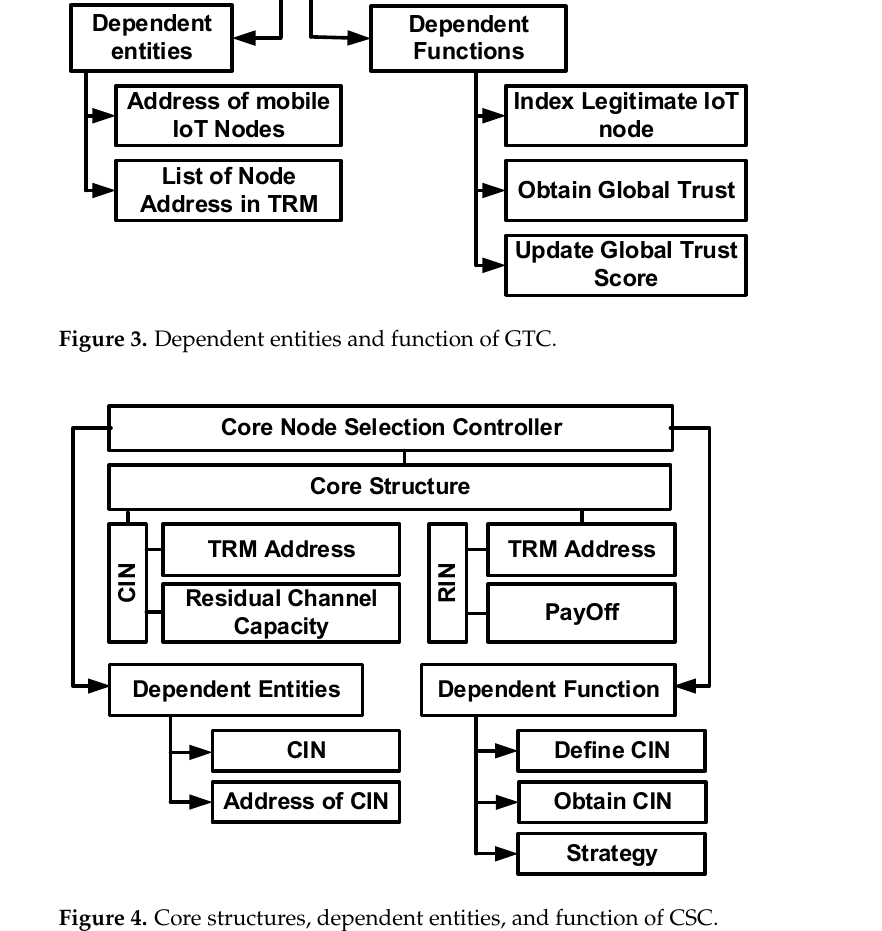
Figure 4. Core structures, dependent entities, and function of CSC.